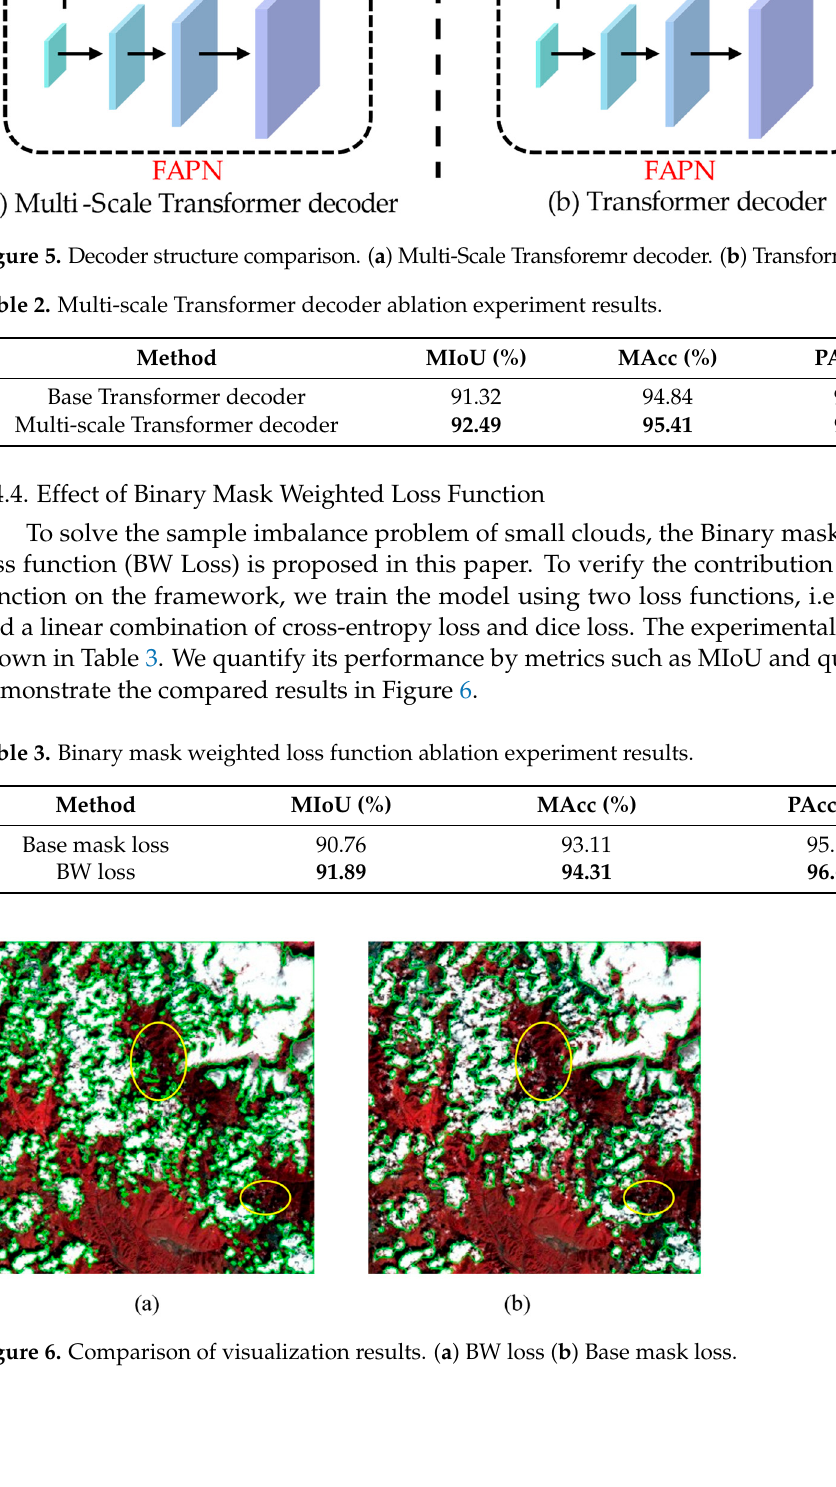
Table 4. Performance Comparison with State-of-the-Art Methods. Method 96.75 Figure 7. Versus different methods on the GF-1 dataset ( a ) Image. ( b ) Cloudformer v2. ( c ) Cloud- former. ( d ) Mask2former. ( e ) SwinTransformer-UperNet. ( f ) GCDB-UNet.